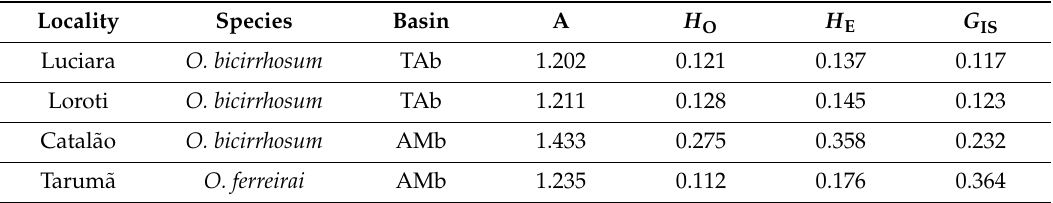
Table 2. Genetic diversity levels of Osteoglossum species. A—average number of alleles; H O —observed heterozygosity; H E —expected heterozygosity; G IS —inbreeding coe ffi